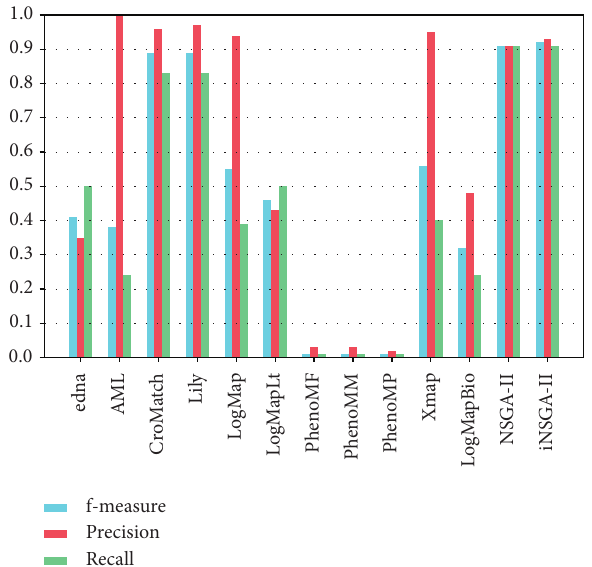
Figure 3: Comparing the results’ quality of different ontology matchers.